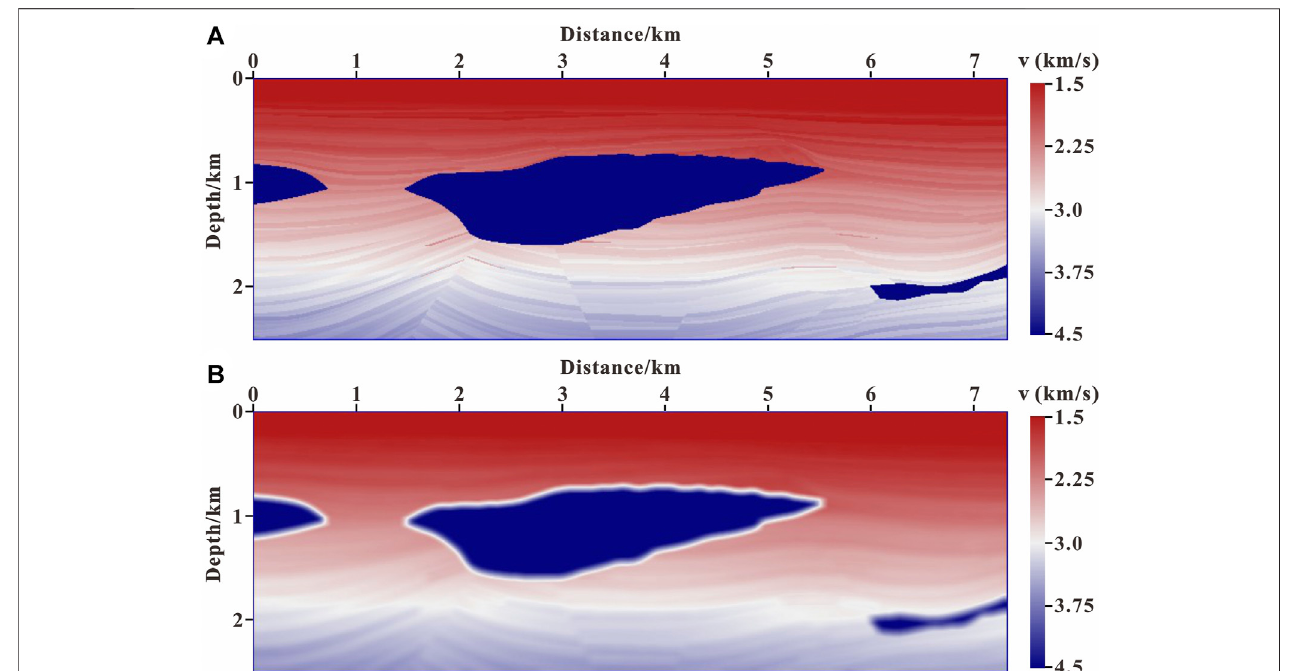
FIGURE 9 | Pluto velocity model: (A) real velocity model; (B) background velocity model.